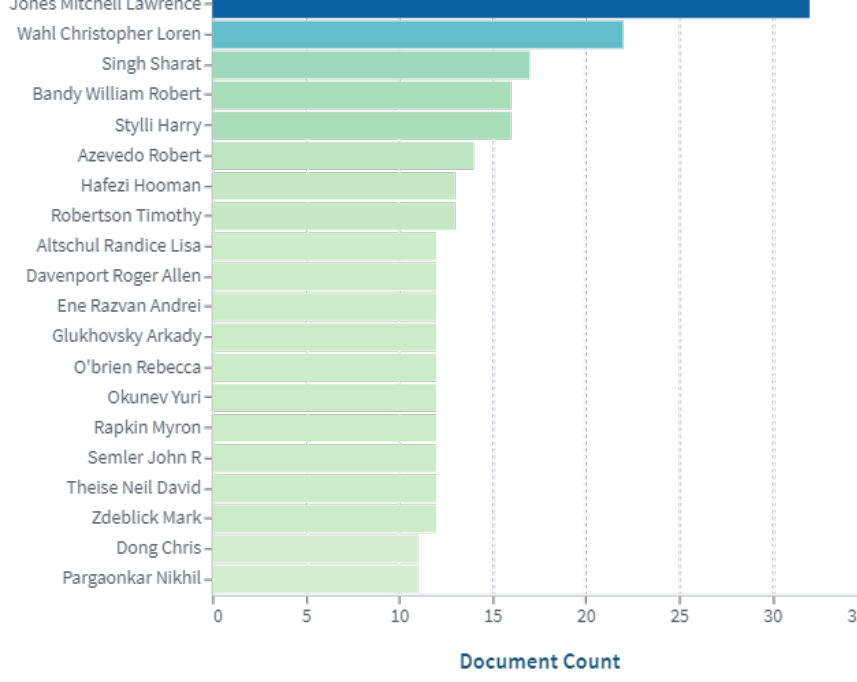
Figure 4. Top inventors of patents in the field of digital pills with ingestible sensor (https://www.lens.org, accessed on 30 July 2022).